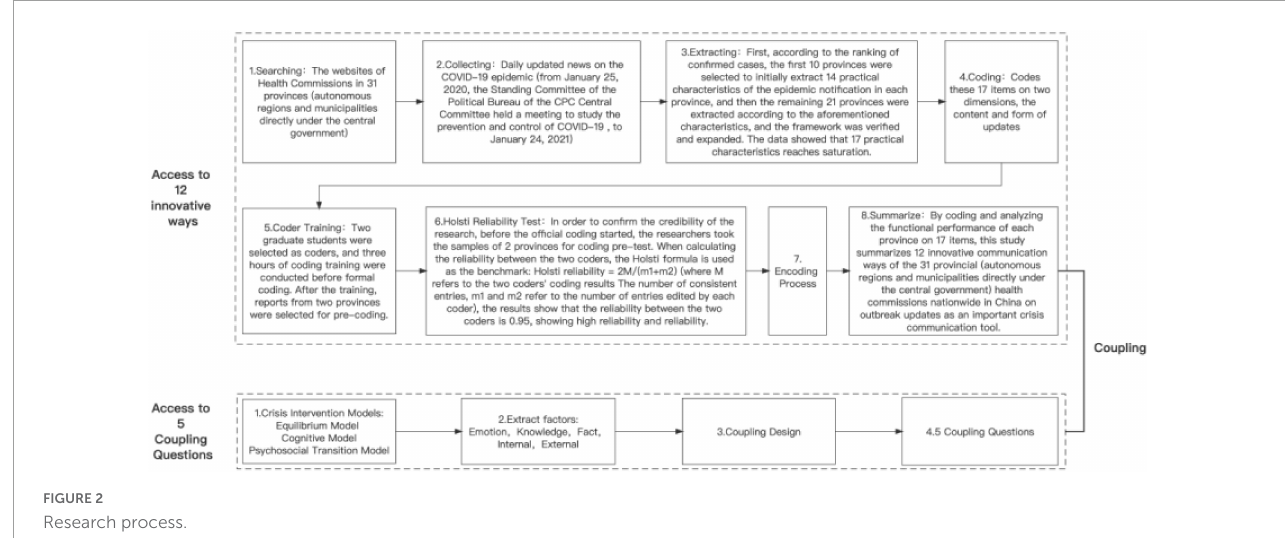
FIGURE2 Research